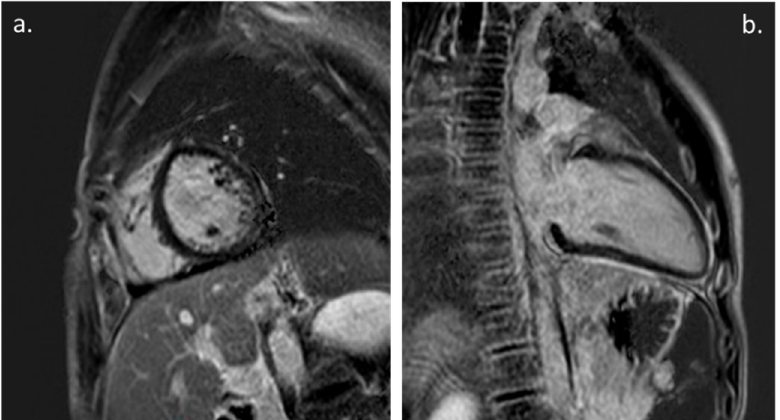
Figure 2. Cardiac Magnetic Resonance: ( a ). PSIR, short axis. Mild LGE with subepicardial pattern involving LV infero-lateral wall. ( b ). PSIR, LV 2-chamber. Mild intramyocardial LGE of the mid-basal inferior wall; also note, persistence of mild pericardial